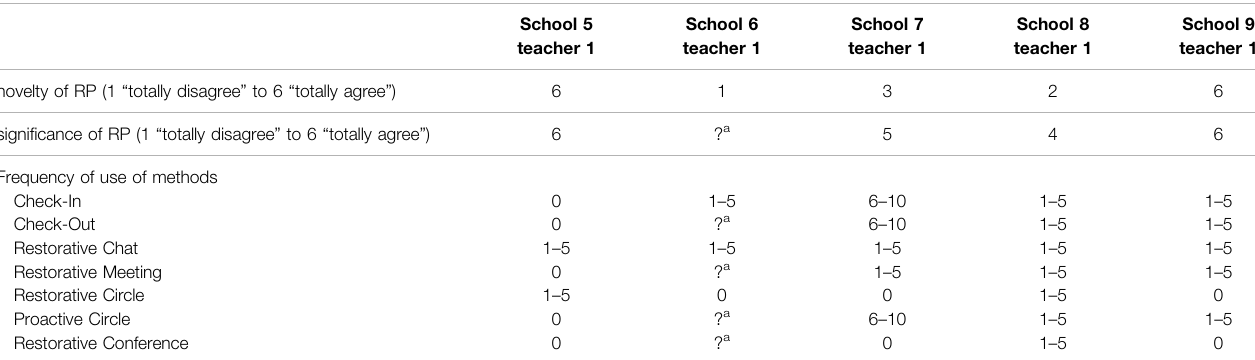
TABLE 7 | Survey of teachers about the practical relevance of the teacher